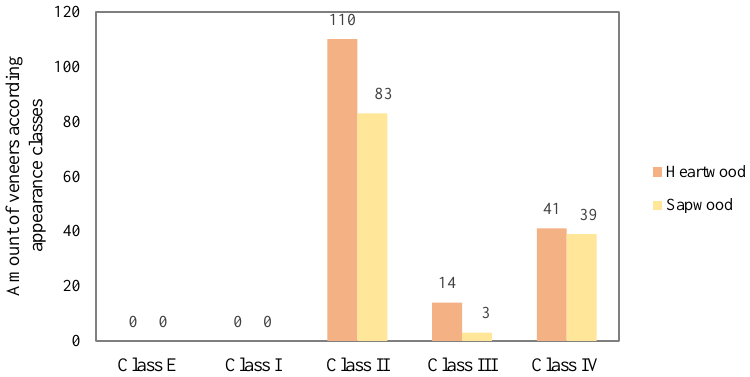
Figure 7. Distribution of veneers by appearance sorting